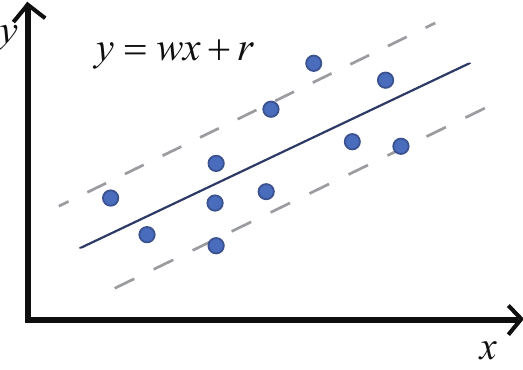
Figure 2. Example of support vector